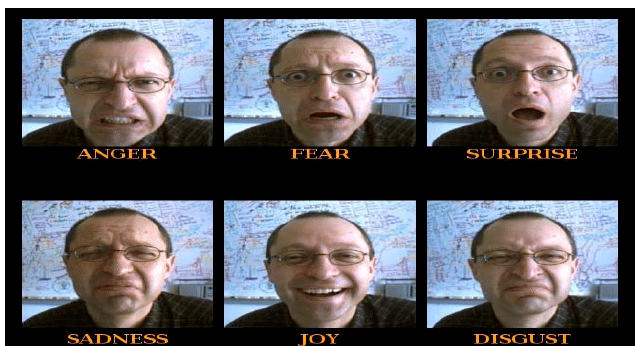
Figure 1. Graphics of the six basic facial expressions (collection one) [46].